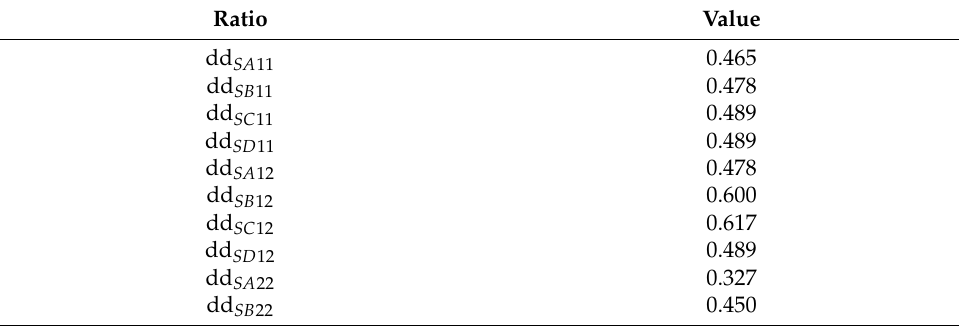
Table A2. The initial division coefficients defining the positions of the points SA ij , SB ij , SC ij , SD ij and the B v ’s vertices of the first structure Σ 1 for i , j = 1,